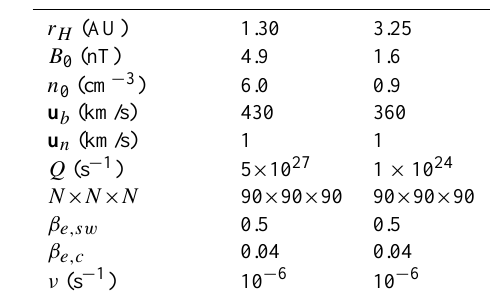
Table 1. Parameters used for the presented